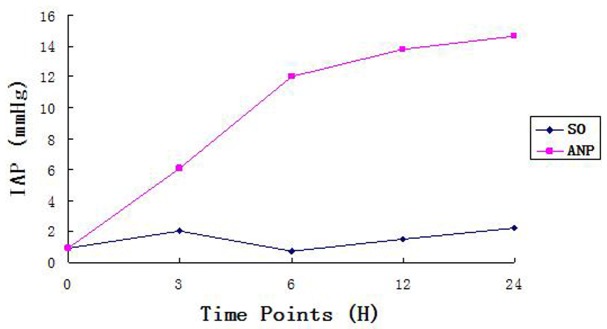
Induction of IAP. Described the variation tendency of IAP in two groups.